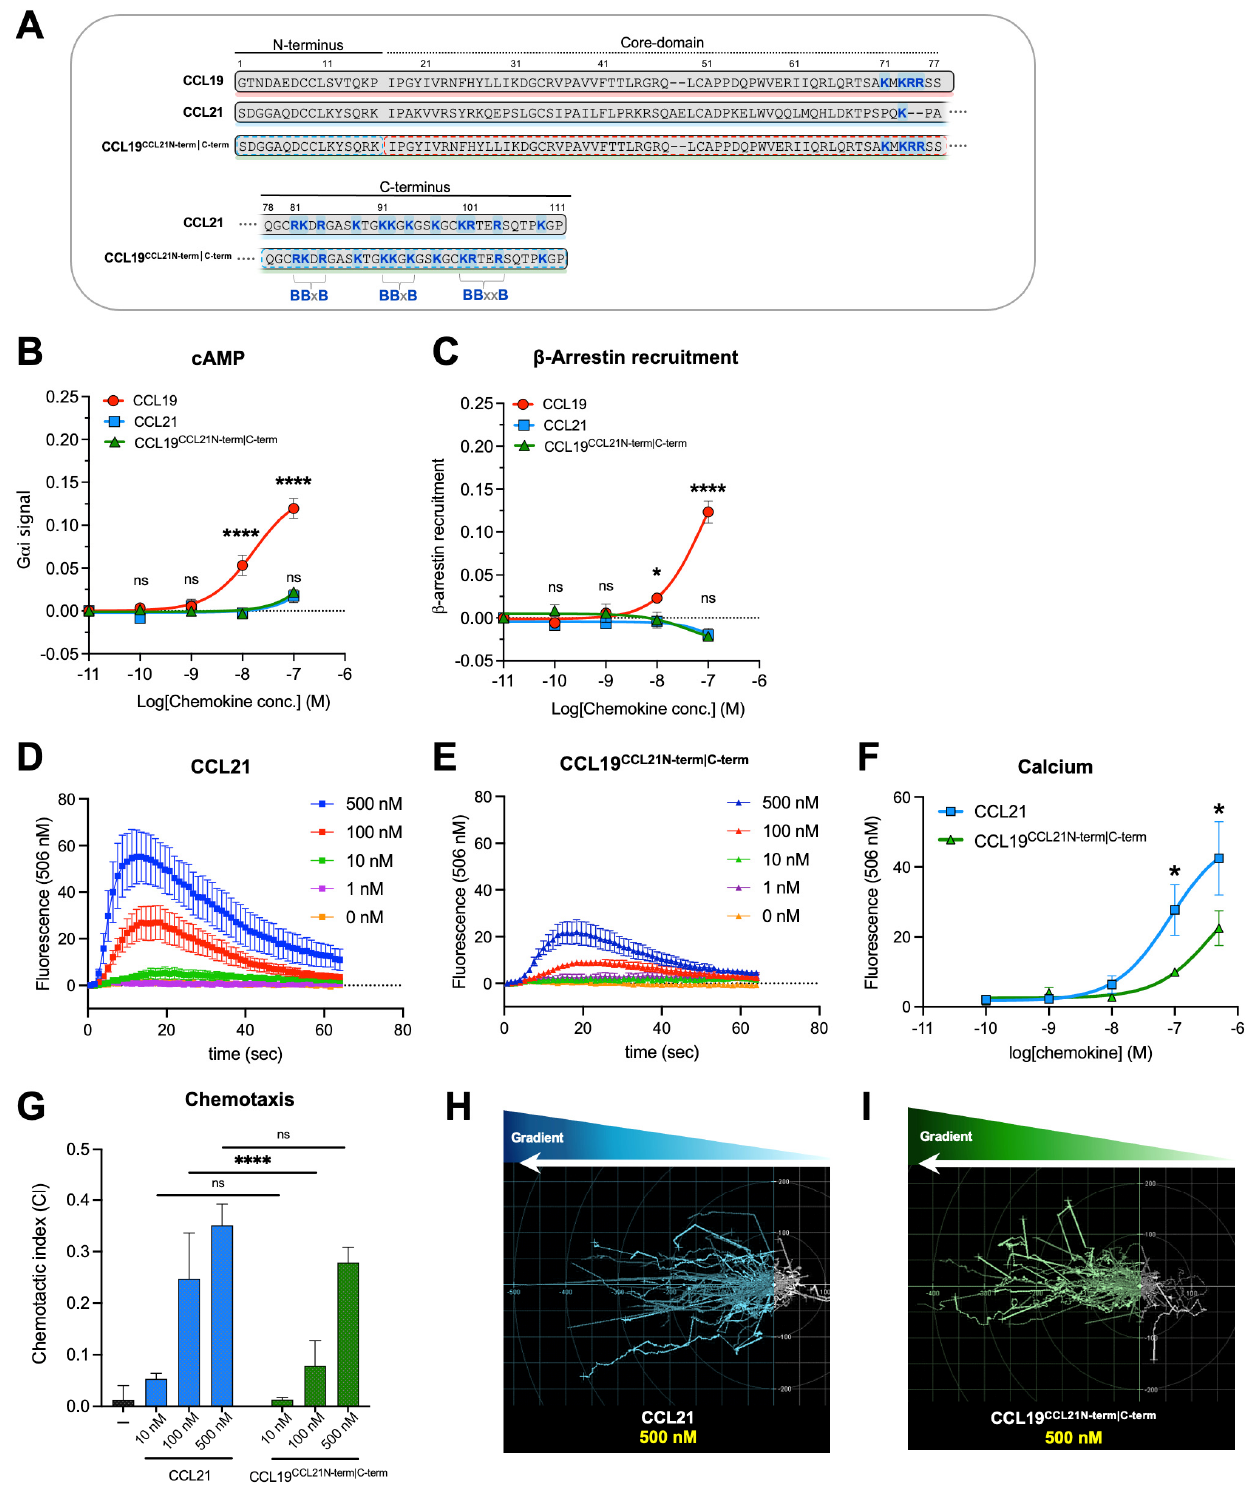
Figure 1. Signaling profiles of CCL19 CCL21N-term|C-term , CCL21, and CCL19 in transfected cell lines and primary cells. ( A ) Alignment of CCL19, CCL21, and the chimeric chemokine CCL19 CCL21N-term|C-term